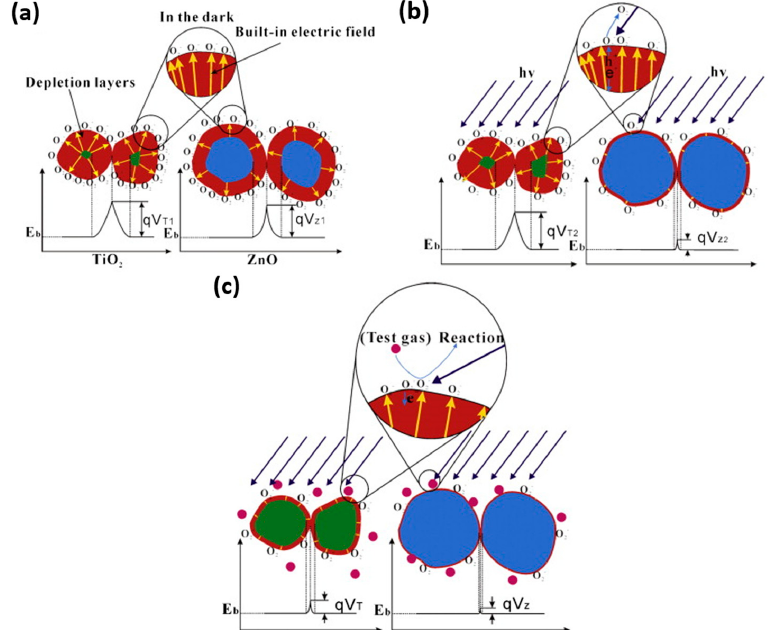
Figure 35. Schematic of surface reactions and corresponding energy barriers ( qV T and qV Z , in which q is the electron charge and V T , V Z are potential barriers of TiO 2 and ZnO, respectively) under different conditions: ( a ) in dry air and in the dark; ( b ) in dry air and with UV light illumination; ( c ) in test gas and with UV light illumination. Reproduced with permission from [64].